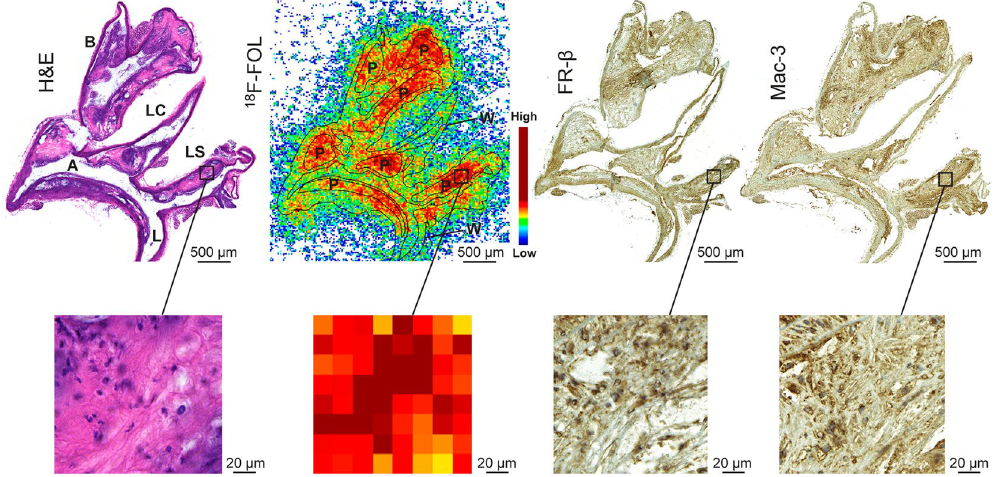
Figure 4. Ex vivo 18 F-FOL autoradiography, histology and immunohistochemistry of mouse aorta. Representative hematoxylin-eosin (H&E), 18 F-FOL ex vivo autoradiograph, FR- β and Mac-3 immunohistochemical staining (macrophages) of adjacent aorta cryosections. The images on the bottom show high-power views of the area within the black rectangle on the upper images. A = arch; B = brachiocephalic artery; L = lumen; LC = left common carotid artery; LS = left subclavian artery. P = plaque; W = healthy vessel